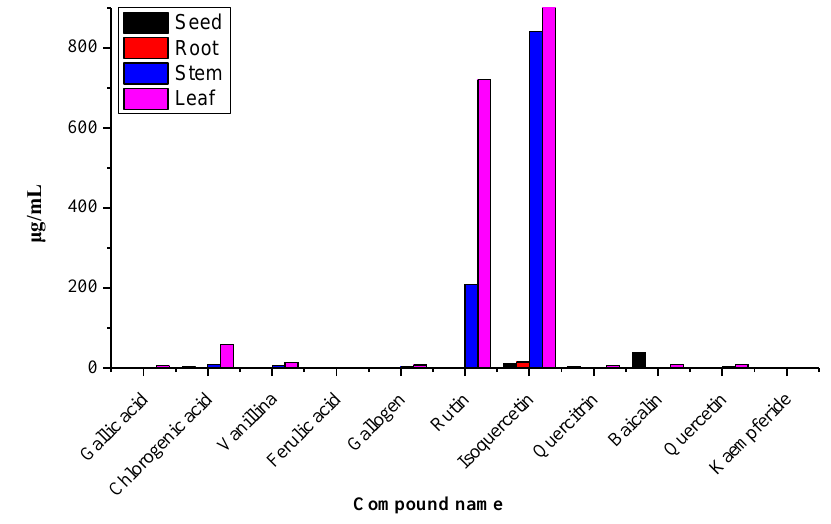
ff erent parts of Moringa oleifera